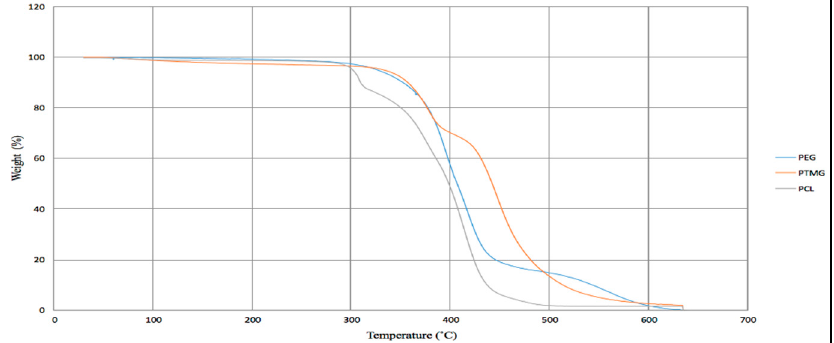
Figure 12. Thermogravimetric curves of three different polyurethane.